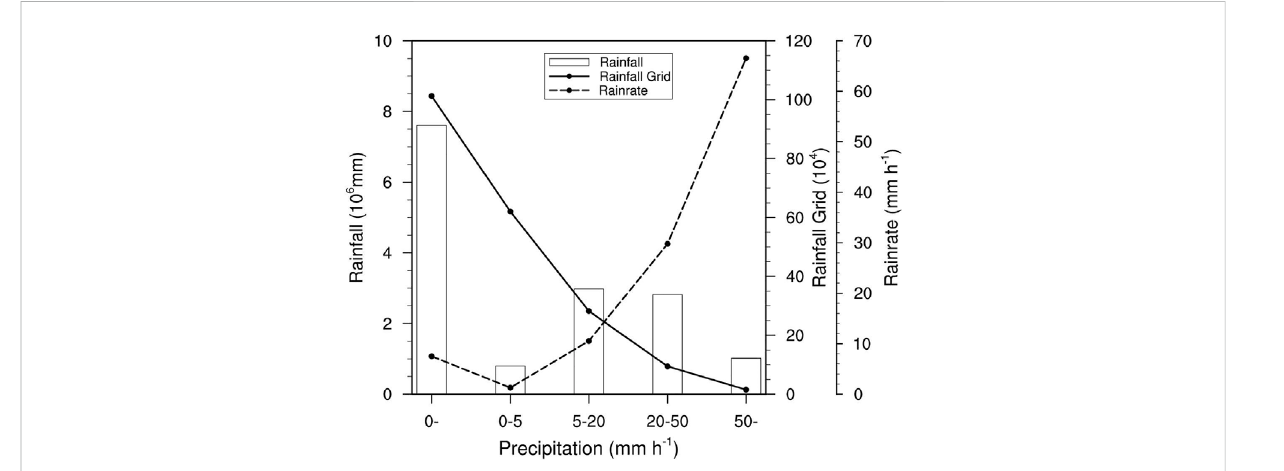
FIGURE 9 Theaccumulationoftotalrainfall(histogram,unit:mm),numbersofgridpoints(solidlines)andtheaveragehourlyrainfallintensity(dottedlines, unit: mm h − 1 ) of different hourly rainfall intensities in the gale circle from 1800 UTC 16 July to 0600 UTC 19 July